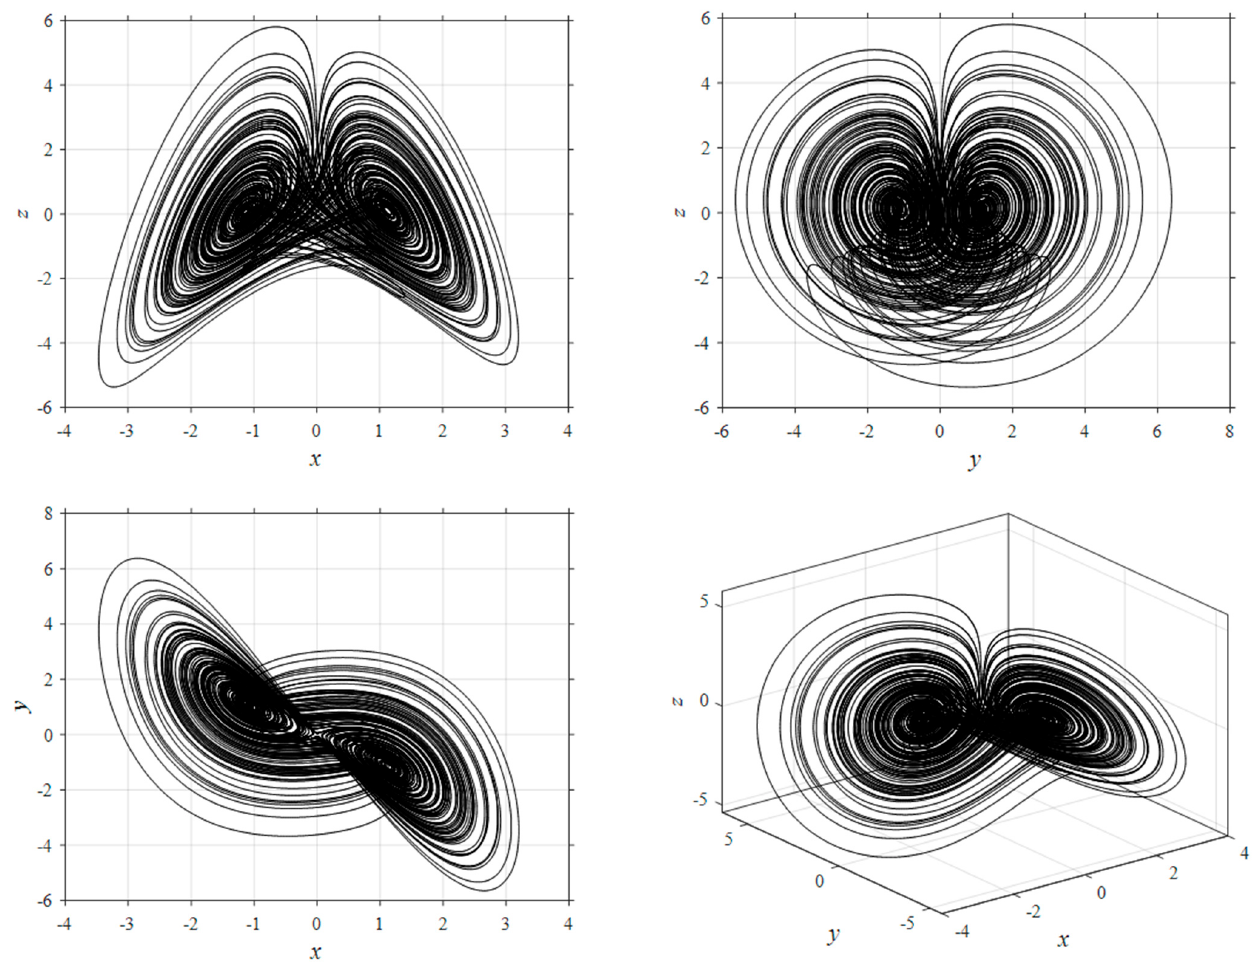
Figure 7. Fractional Burke-Shaw system chaotic attractor using SINC-DQM with time ( T = 100 ) and fraction λ = 1.1, γ = 0.97, a = k = g = 10, d = 13, and x ( 0 ) = 0.1, y ( 0 ) = 0.1, z ( 0 ) =